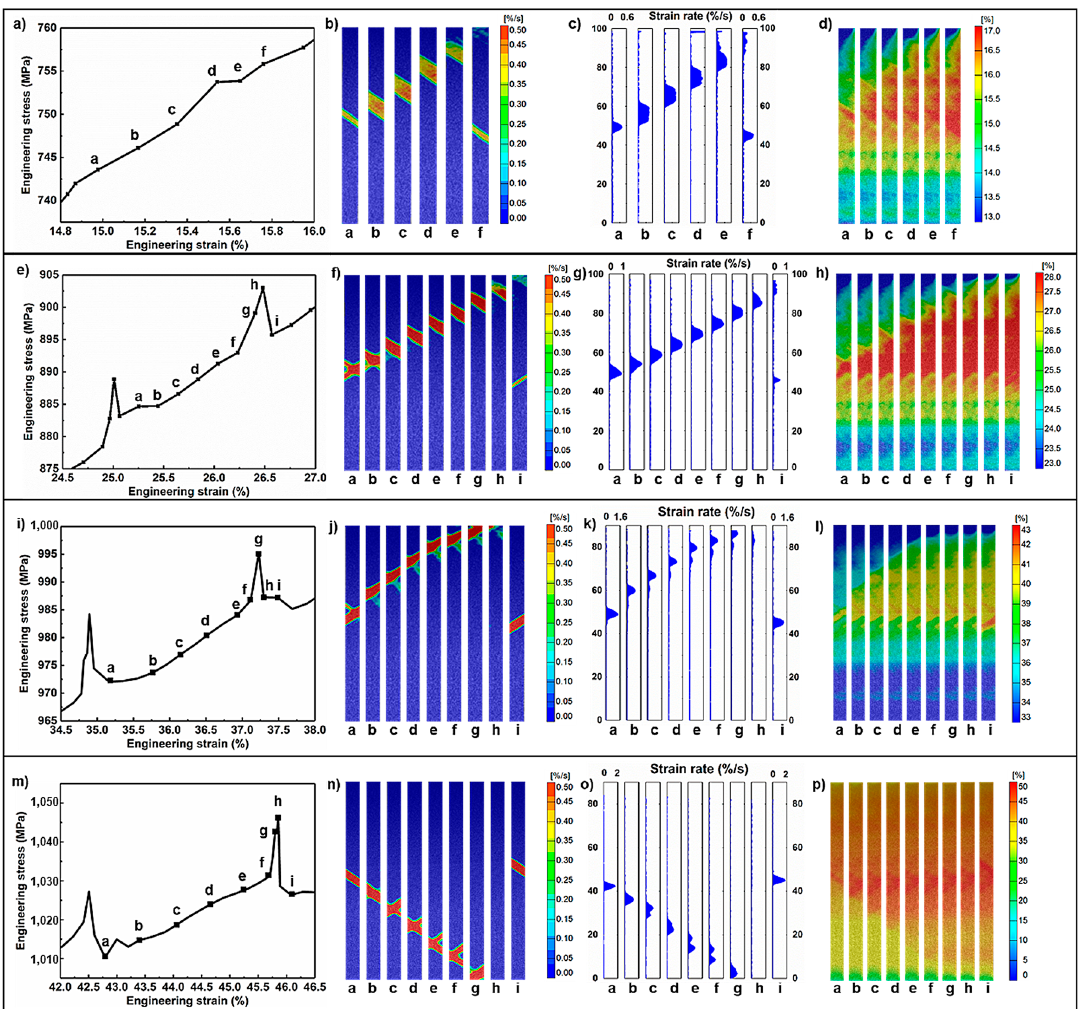
Figure 3. Serrated flow, strain rate contour, strain rate distribution and strain distribution along tensile direction at strains of approximately 15% ( a – d ), 25% ( e – h ), 35% ( i – l ) and 45% ( m – p ).